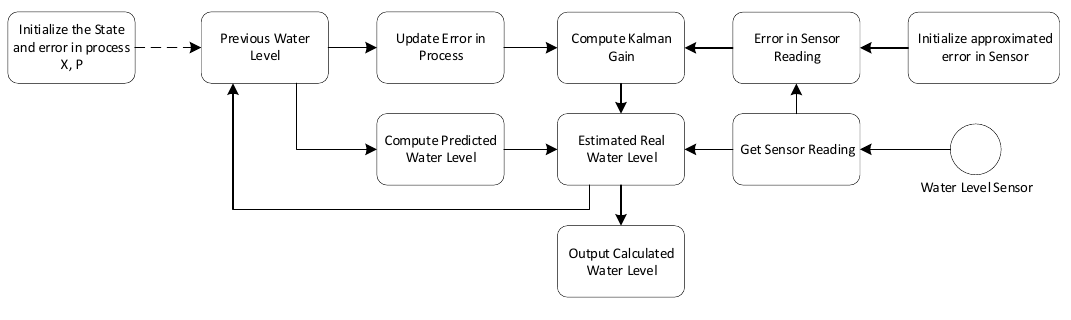
Figure 4. Kalman filter algorithm for water level